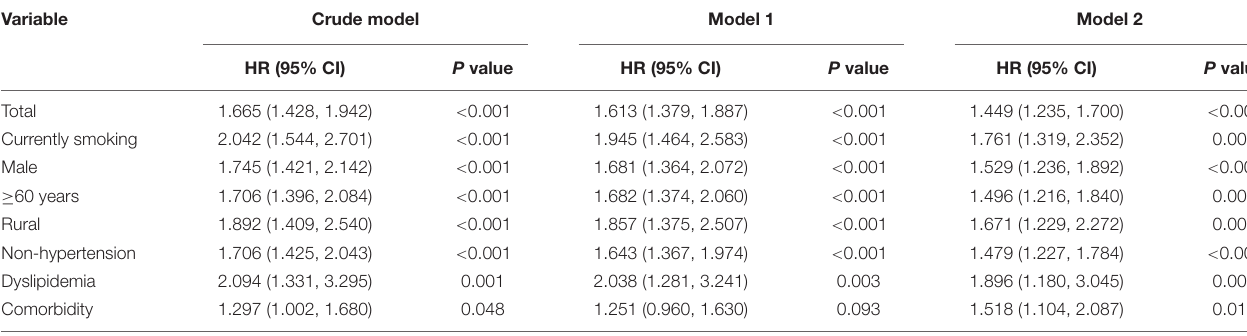
TABLE 4 | HRs and 95% CI of baseline CLD status for depressive symptoms incidence. Variable